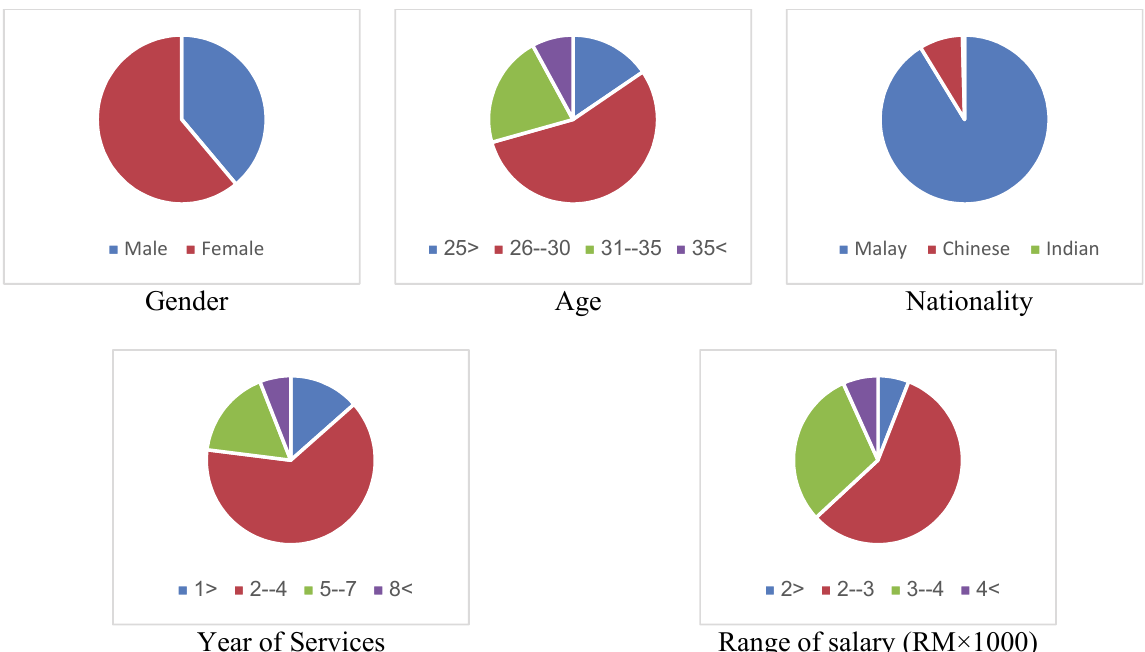
Fig. 1. Personal characteristics of the